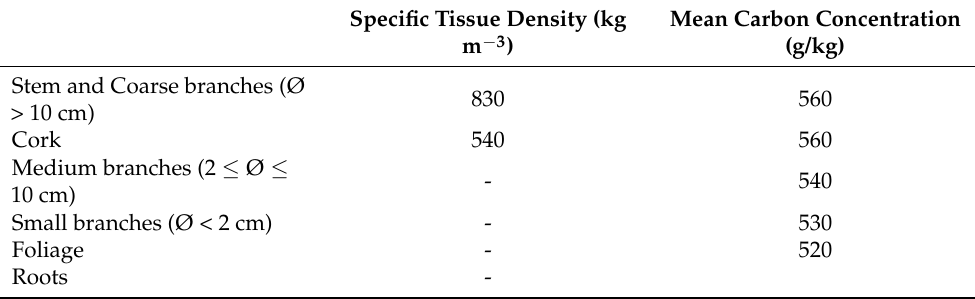
Table A1. Specific tissue density and mean carbon concentration of the tissues adapted from [40].